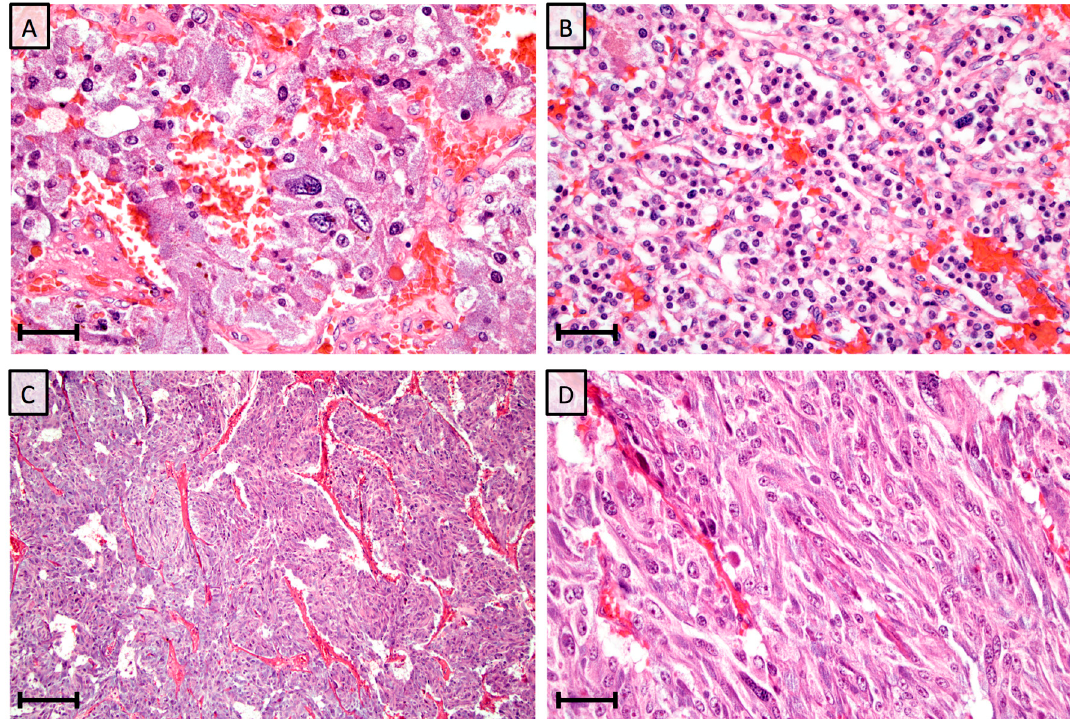
Figure 1. Photomicrographs of metastatic ( A , B ) and non-metastatic ( C , D ) pheochromocytoma cases with elevated PASS scores previously diagnosed at our institution. Scale bars are 25 micrometers for A , B and D , and 100 micrometers for C . ( A ) Nuclear pleomorphism in a pheochromocytoma with a total PASS score of 8. This tumor was resected from a 61-year old female who developed metastatic disease 9 years after initial diagnosis. ( B ) Same case displaying hypercellularity and nuclear hyperchromasia, two additional parameters included in the PASS algorithm. ( C ) Large and irregular nests in a pheochromocytoma with a PASS score of 7, diagnosed in a 41-year old male. The patient is alive without metastatic disease after 20 years of follow-up. ( D ) Same case displaying focal tumor cell spindling with elongated nuclei, a phenomenon yielding two PASS points.